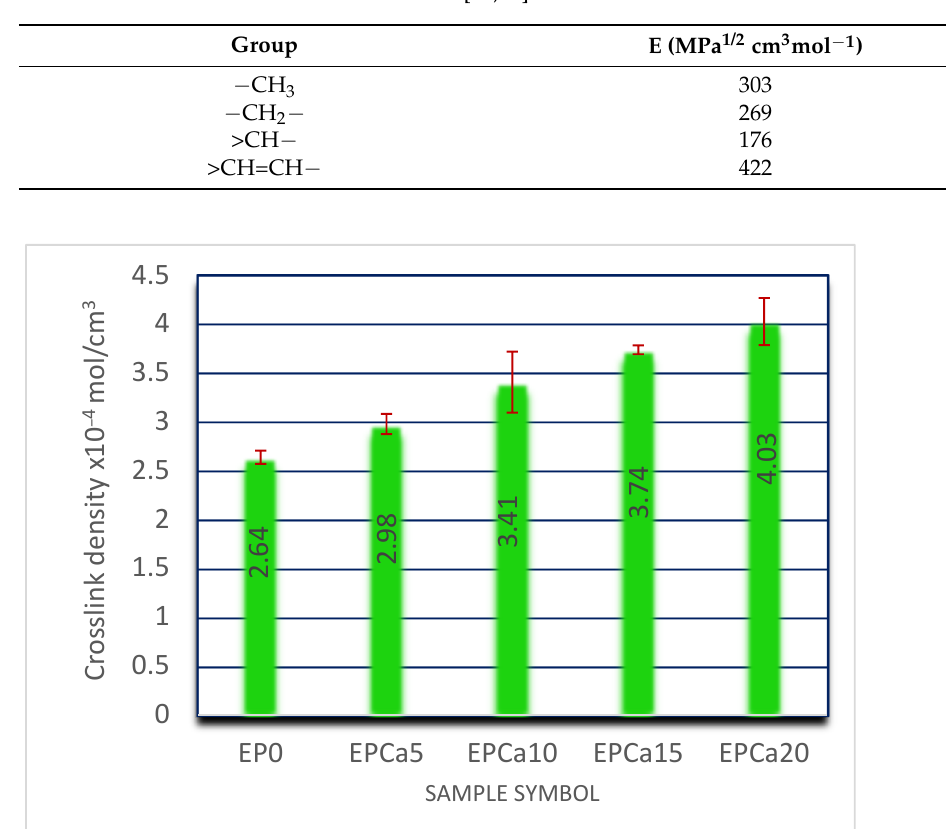
Figure 2. Variation in crosslink density with fiber loading for EPDM/hemp fiber composites.